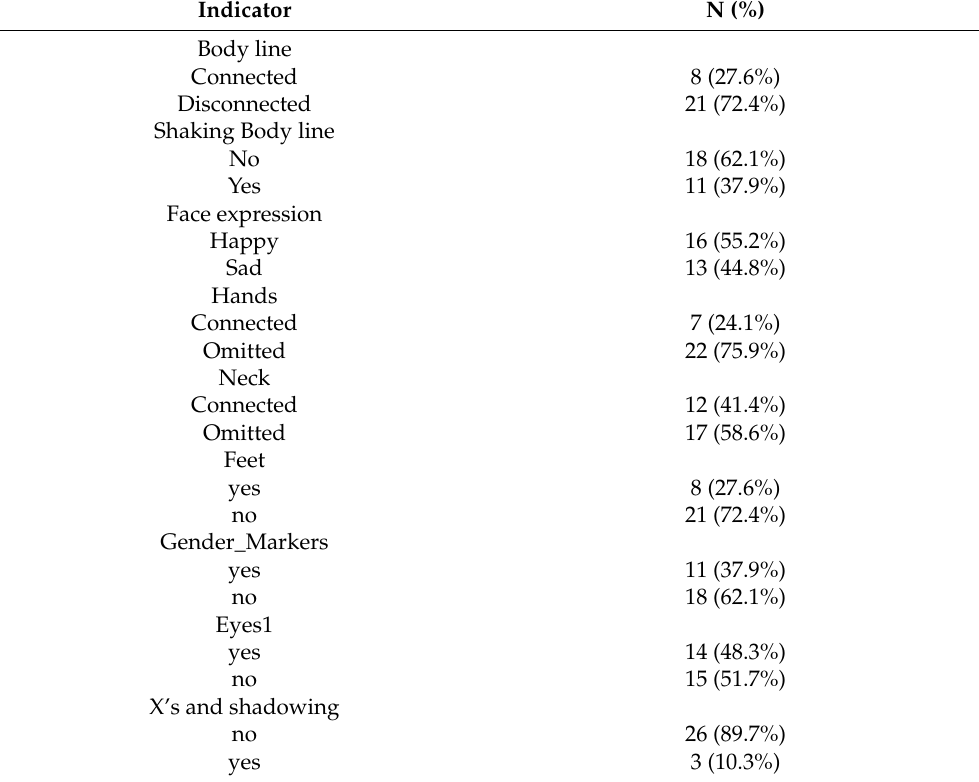
Table 3. Drawing indicators for drawing of the self before diagnosis, N = 29.